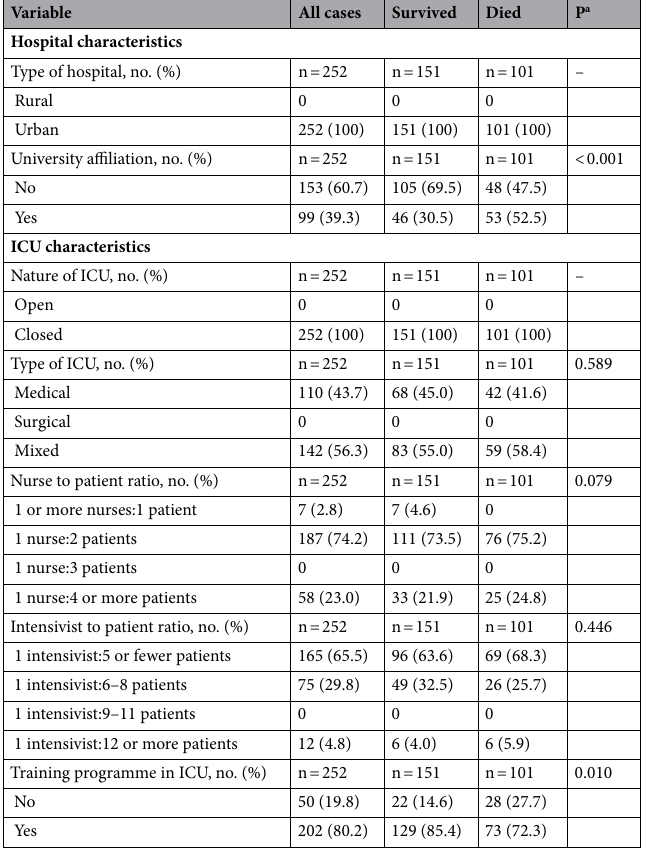
Table 1. Hospital and intensive care unit characteristics according to hospital survivability of patients with sepsis. ICU intensive care unit, no. number. a Comparison between survived and died patients with